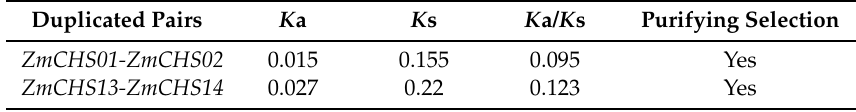
Table 3. K a/ K s analysis for the duplicated ZmCHS paralogs.